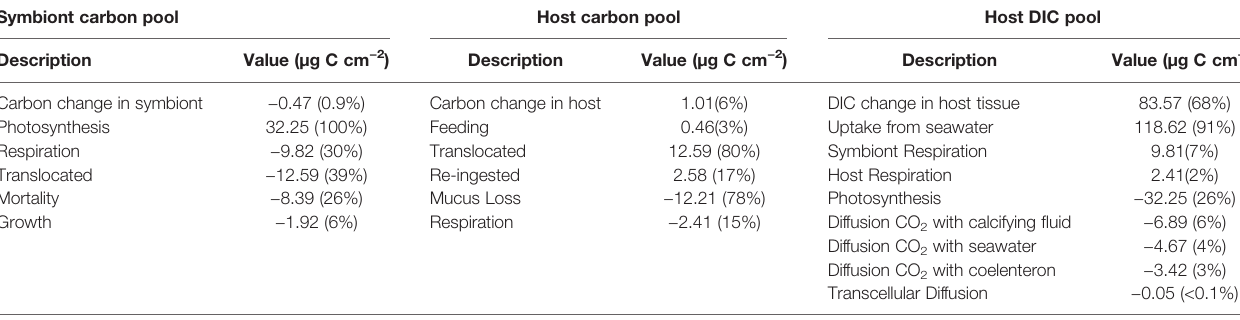
TABLE 7 | Daily carbon budget in the symbiont carbon pool, host carbon pool, and host tissue inorganic carbon pool.